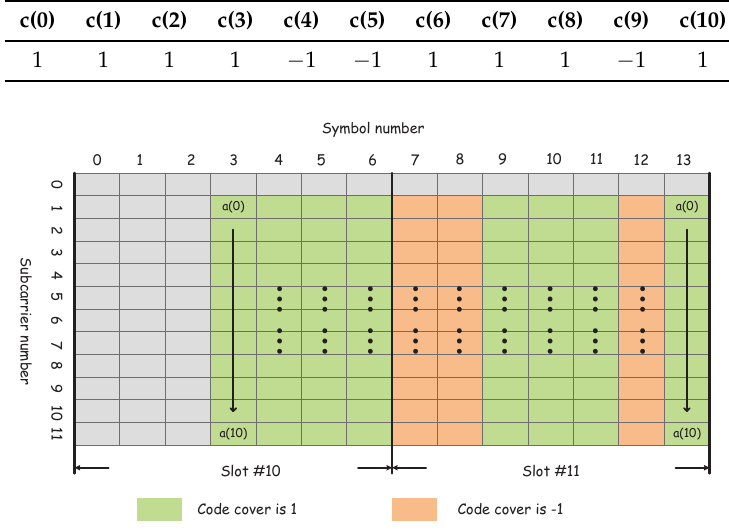
Figure 2. Diagram of the mapping of NPSS resource elements in slots 10 and 11. The time region starts from symbol 3 to 13, and the frequency region starts from subcarrier 1 to 11.